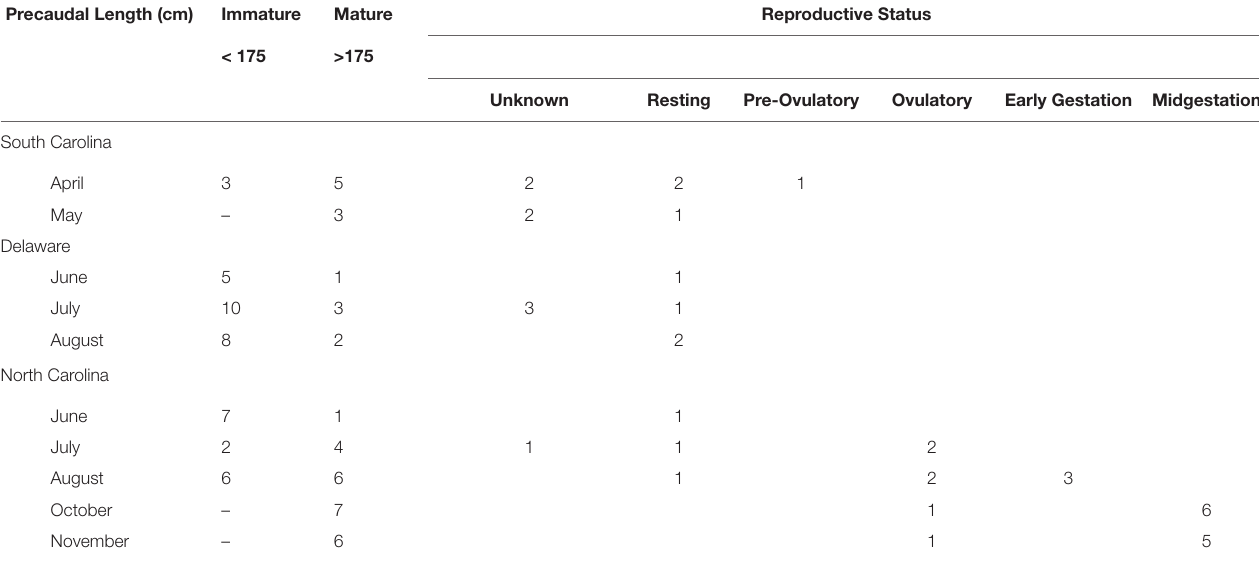
TABLE 2 | Size and sampling locations for in situ sand tiger sharks Carcharias taurus . Precaudal Length